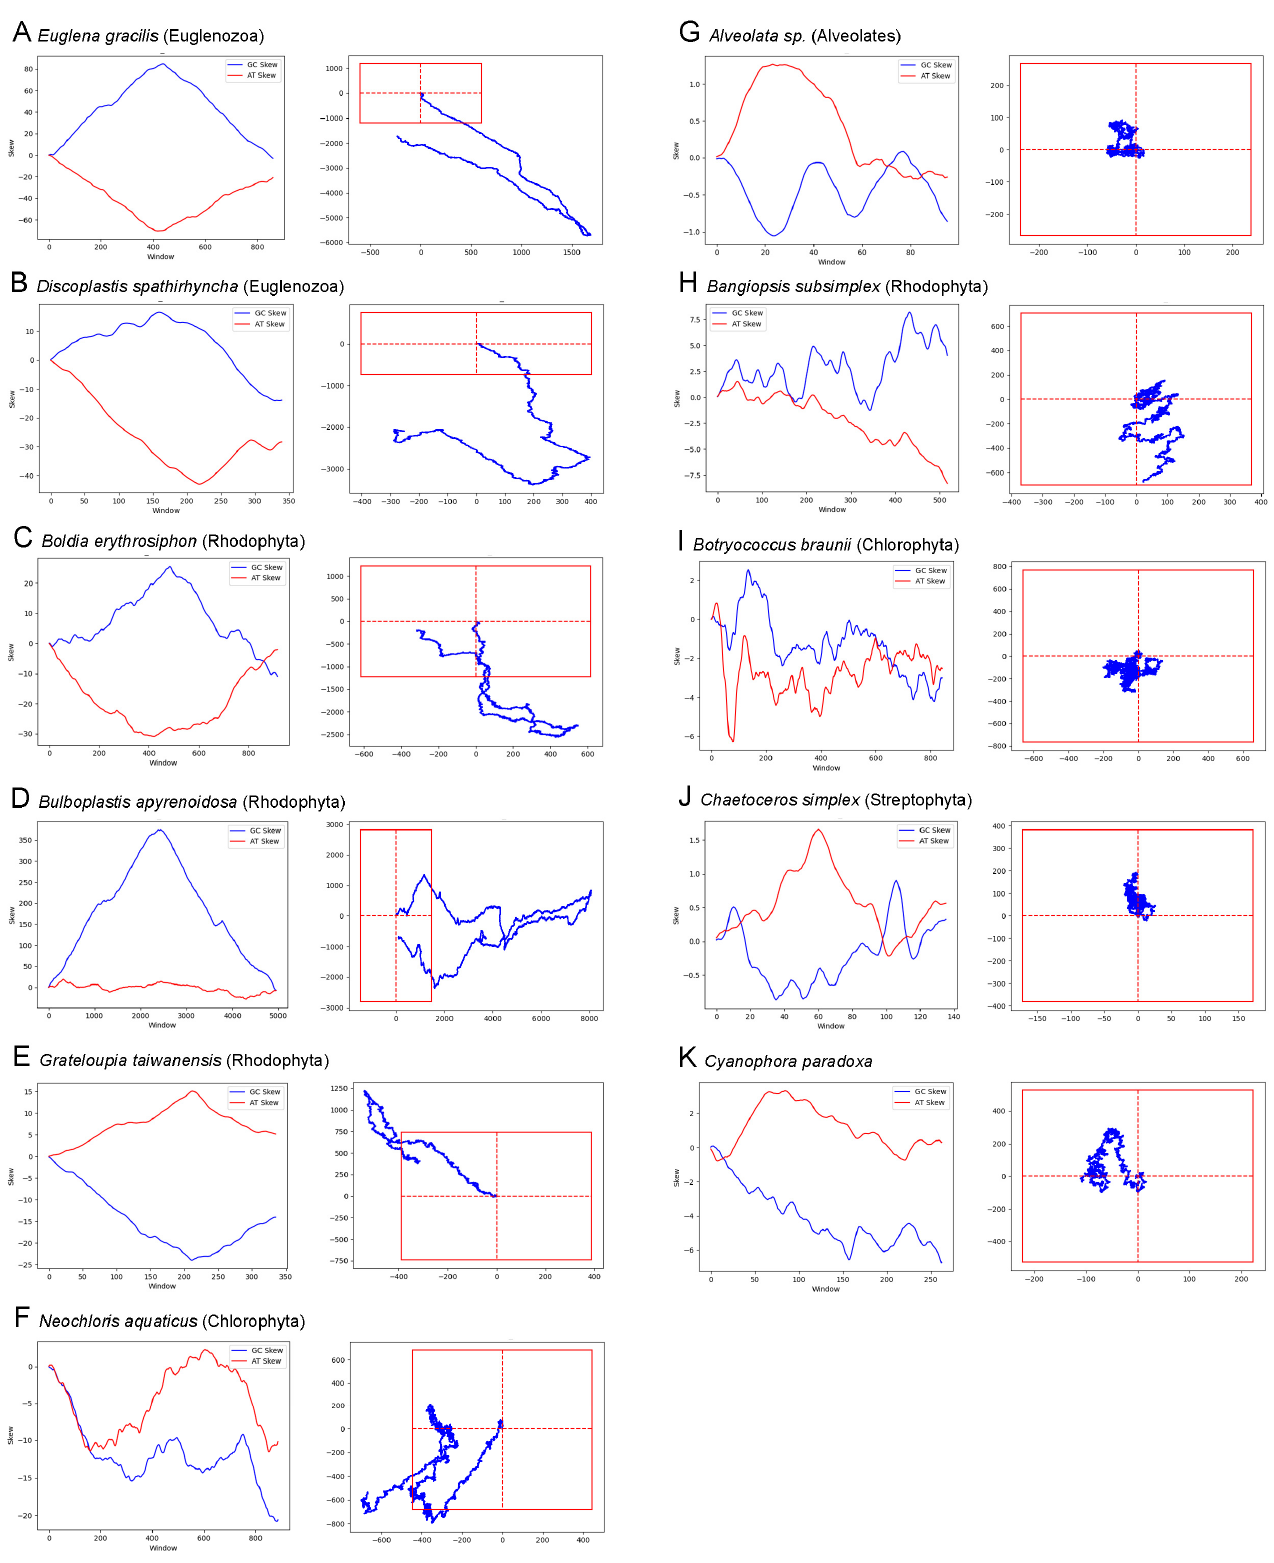
Figure 2. Skew plots and walks for 6 representative genomes with evidence for a skew pattern ( A–F ) and 5 that do not ( G – K ). The skew was calculated using a window size of 1000 and an overlap of 100. For the genome walks, the direction of change for each base is indicated; the AT walk is on the vertical axis and the GC walk along the horizontal axis. The origin of each walk is the intersection of the dashed red lines and the outer box represents the significance point as described in Section